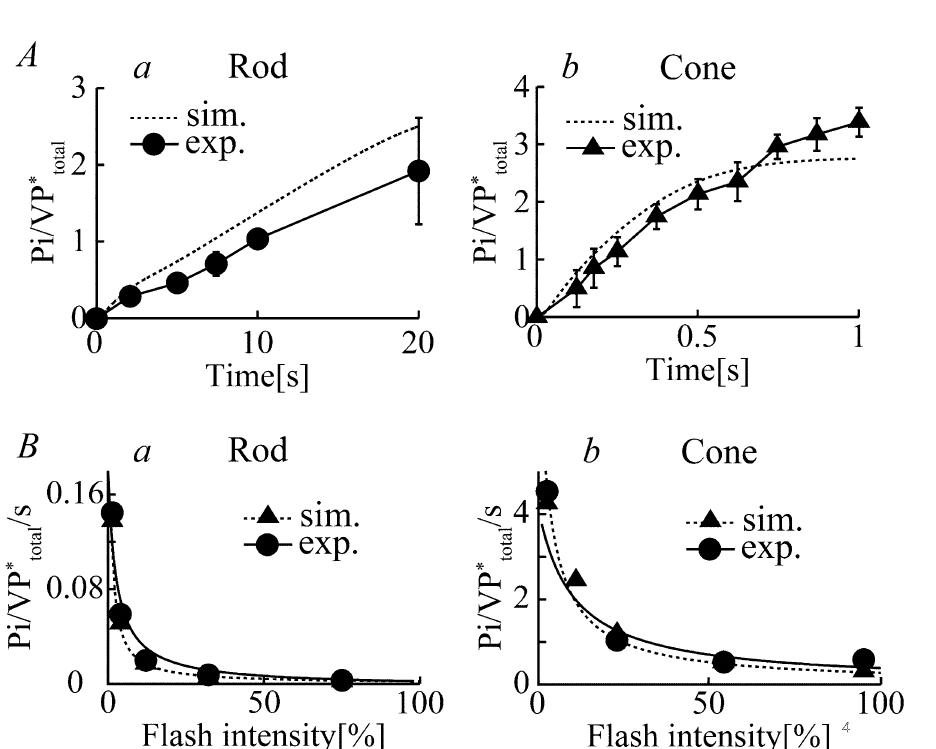
Figure 2. Phosphorylation of visual pigments in rods and cones. ( A ) The time courses for the phosphorylation of VPs (the number of phosphate groups incorporated into an activated visual pigment molecule) measured in the membrane preparations of purified frog rod (a, circle) and carp cone (b, triangle) in response to light flash at 1.3% and 2.5%, respectively, in the experiments 17 . The corresponding simulation results (dotted lines in a and b) are also shown in the figures. ( B ) Maximum rates of phosphorylation reaction per activated visual pigment at different flash intensities in rods (a, circle) and cones (b, circle), determined 10 s and 0.6 s after light stimuli, respectively (data modified from Tachibanaki et al. 17 ). Experimental results were fitted by the Michaelis–Menten equation (V/S = Vmax/(S + Km), solid lines). Simulated responses for both the carp rod (a, dotted line triangle) and cone (b, dotted line triangle) were superimposed onto the experimental